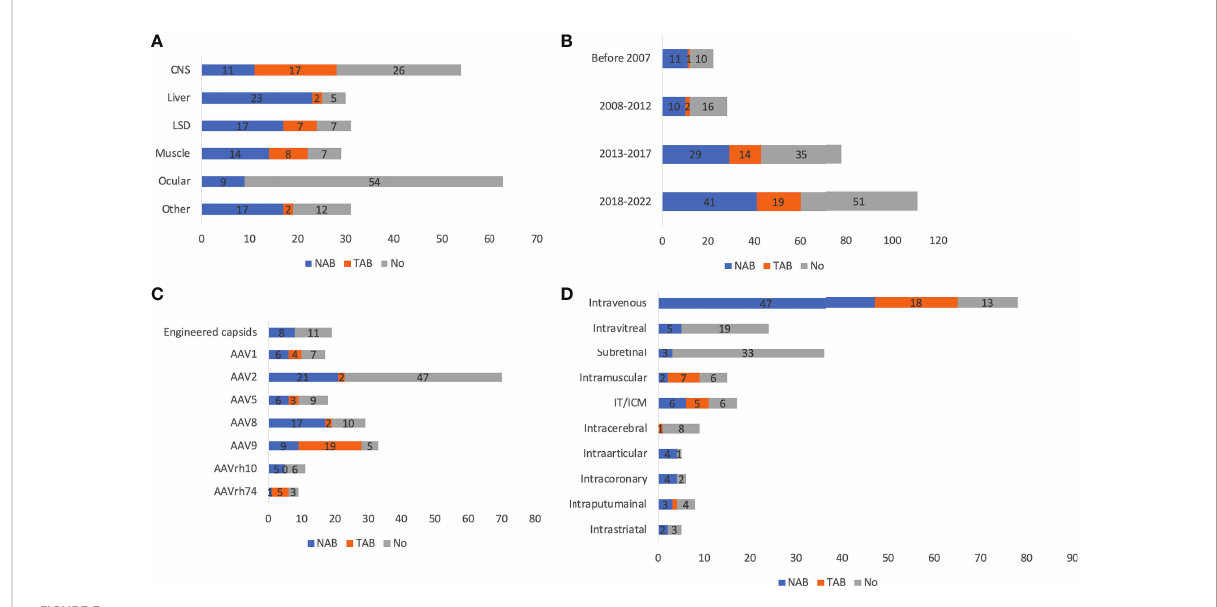
FIGURE 3 Antibody assays of 255 AAV clinical trials by disease indications (A) , timeframe (B) , serotypes (C) , and ROAs (D) . ROA and serotypes associated with <10 trials are not included in the fi gure. IT and ICM were combined due to the high similarity. Trials that indicated usage of antibody assays but did not specify types of assays are not